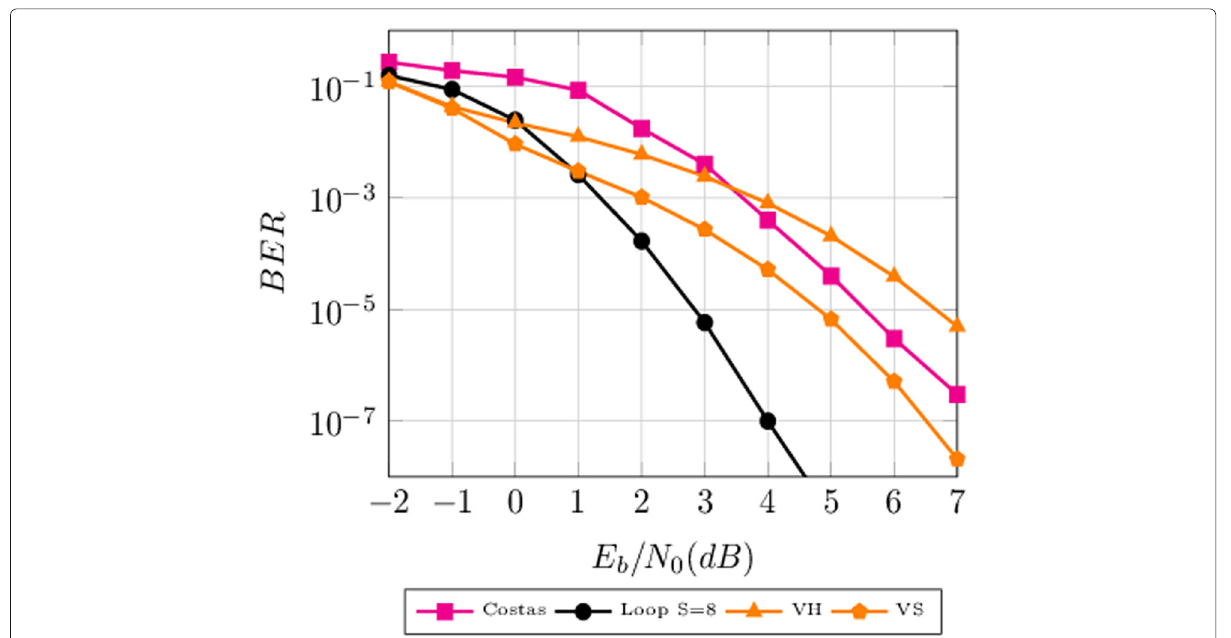
Fig. 7 Simulated error rate of proposed recovery loop (loop), Costas’ loop, Viterbi hard (VH), and soft (VS). The proposed recovery loop gains 2.5 dB in SNR when BER is 10 −